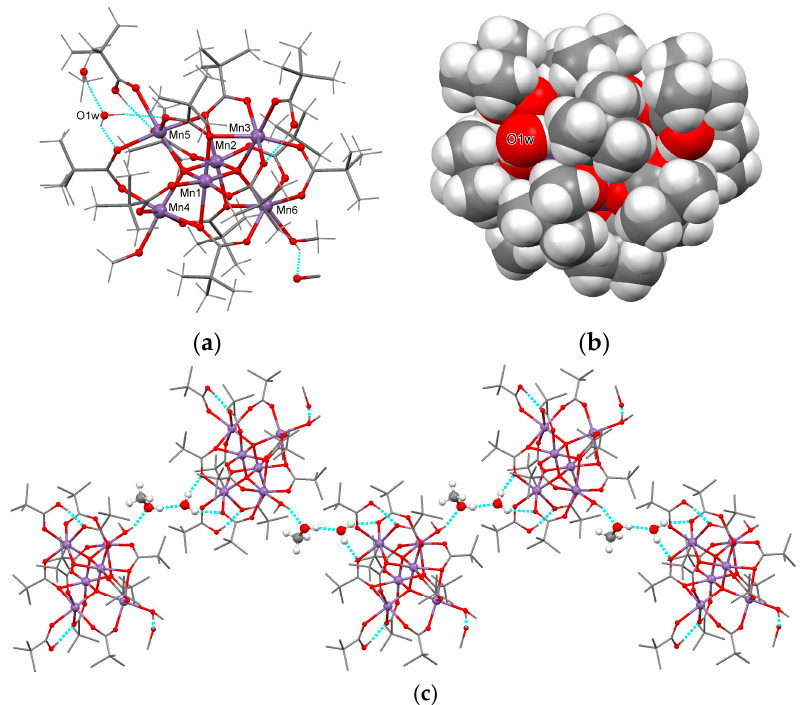
Figure 3. ( a ) View of the formula unit of 3 . The second position of the disordered groups/molecules is not shown. ( b ) Space-filling model illustrates the position of the interstitial solvent water molecule on the cluster surface. ( c ) Zigzag-like H-bonded polymeric chain of clusters. The water-methanol H-bonded associates are highlighted by bigger radii balls.